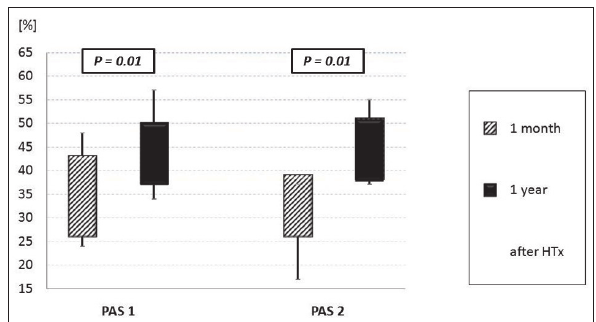
Fig. 6. DTA progression over one year = PAS1 + PAS2 PAS = percent area